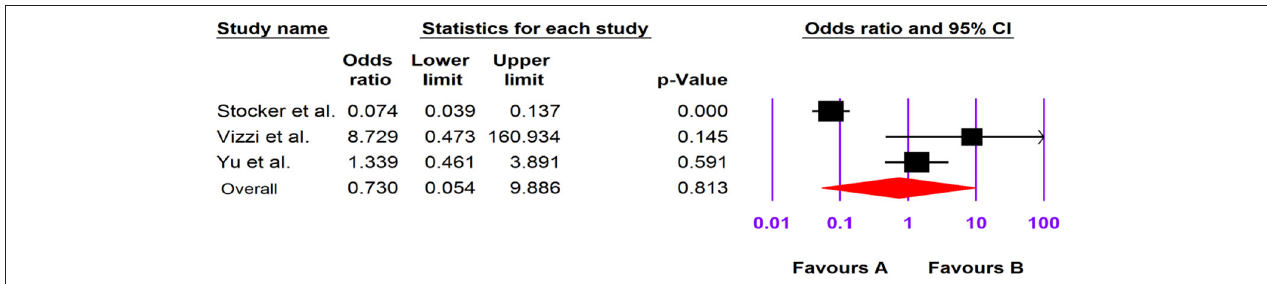
FIGURE 7 | Forest plot of odds ratios for the HCosV based on case-control studies.